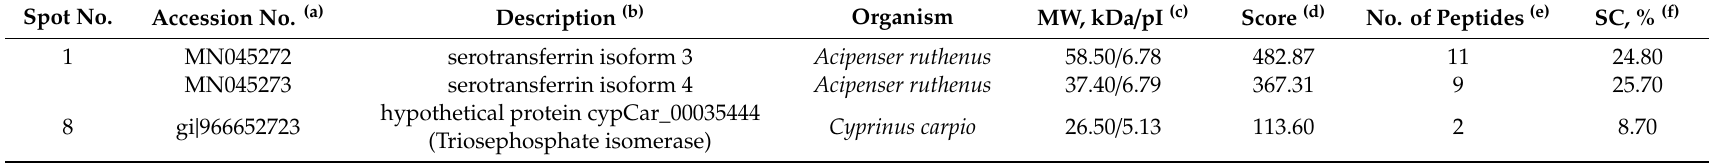
Table 3. List of proteins identified in the seminal plasma of sterlet ( Acipenser ruthenus ). Spot No.